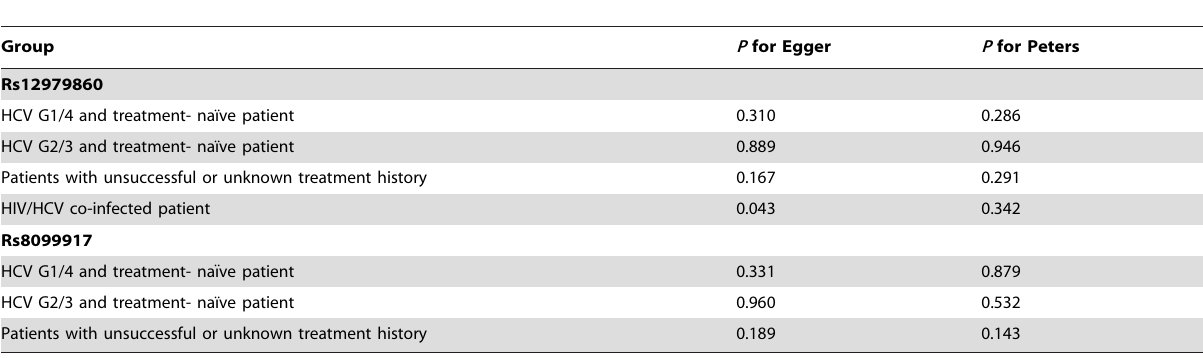
Table 3. Results for publication bias test using Egger’s test and Peters’